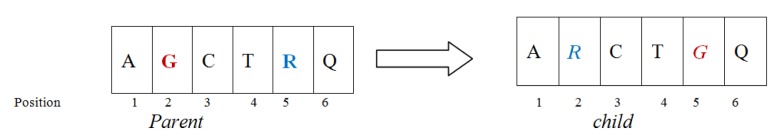
Reverse Mutation operator